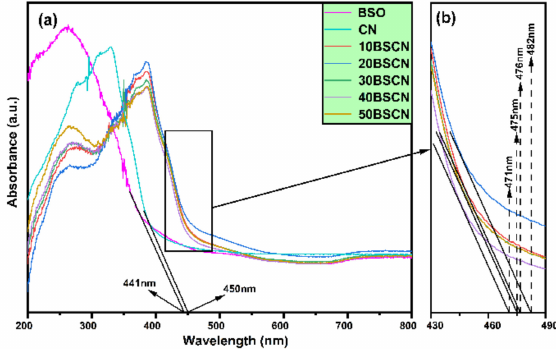
Figure 5. The UV–Vis diffuse reflection patterns ( a ) and the high-resolution pattern ( b ).